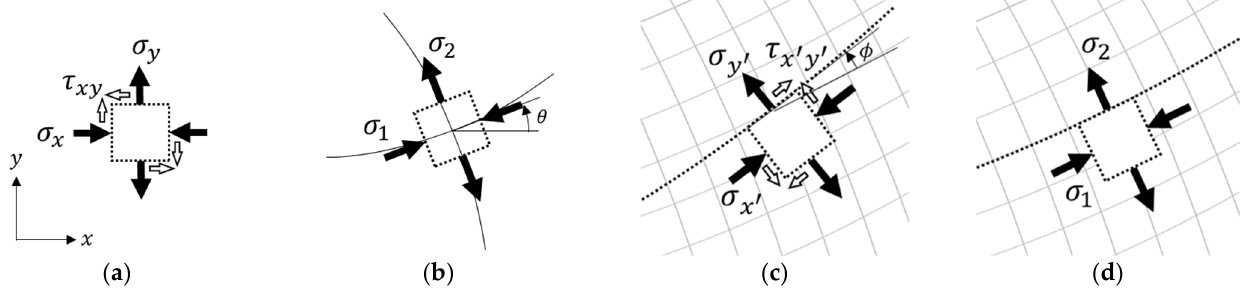
Figure 3. Stress in the device. ( a ) Normal and horizontal shear stress in the grasped device in a high-stiffness state. ( b ) The wavy-shaped beam and stress while the device is grasped and pulled.